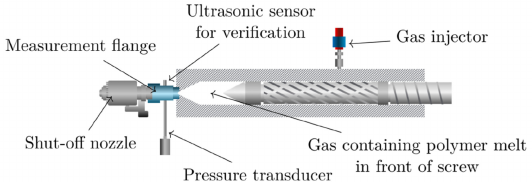
Figure 1. Schematic representation of the plasticizing unit on an injection molding machine equipped for solubility measurements (shut-o ff nozzle and gas injector are standard equipment for foam injection molding; measurement flange, pressure transducer, and ultrasonic sensor are mounted specifically for the purpose of bulk modulus measurements).